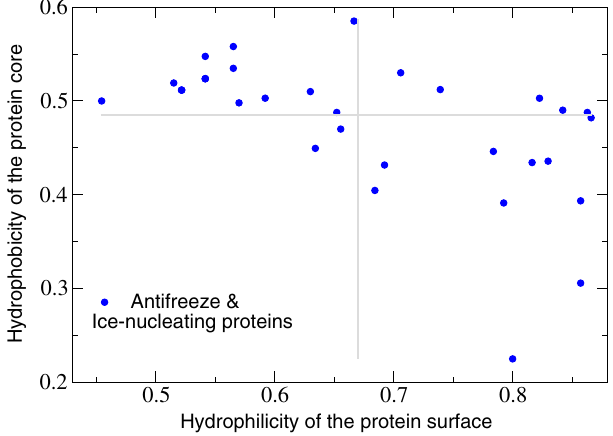
FIG. 7. Hydropathy of the protein surface and the protein core of the ice-binding